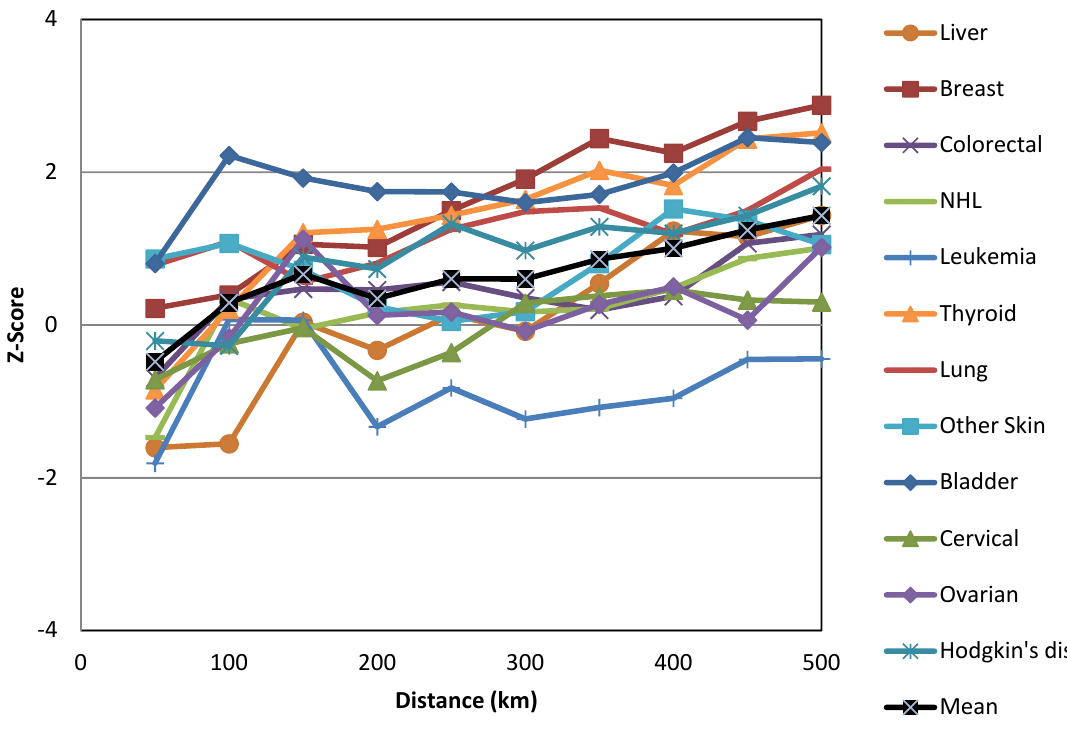
Figure 4. Z-scores of the global Moran’s I statistics for the most common cancers in